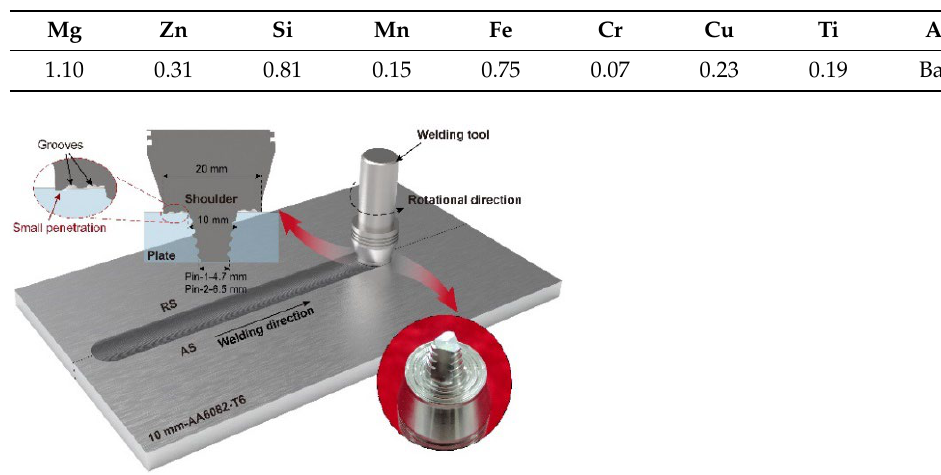
Figure 1. Schematic of micro-weld thinning FSW process. Table 1. Chemical compositions of AA6082-T6 ( wt% ).